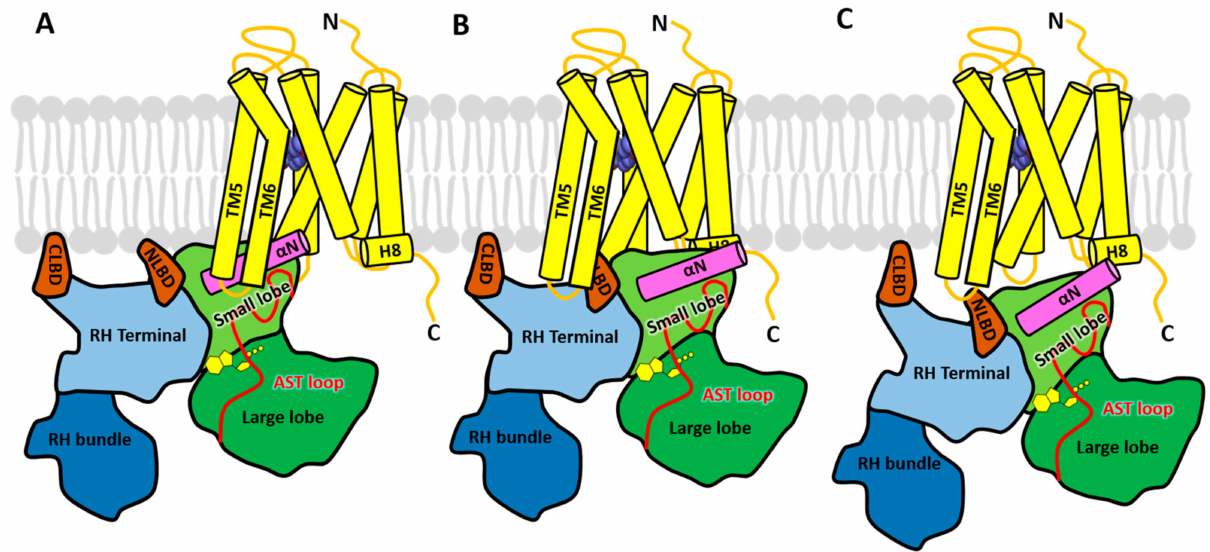
Figure 2. Three models of the GPCR–GRK complex. GRK5 is modeled in complex with the β 2 -adrenergic receptor (yellow cylinders) bound to the agonist epinephrine (purple spheres). The coloring of the structural domains of GRKs is the same as in Figure 1. ( A ) Model 1, in which the N-terminal helix ( α N) forms the primary docking site, was conceived based on crystal structures of GRKs and functional studies of mutants in each of the three GRK subfamilies, and modeled based on similarities with known heterotrimeric G protein complexes with receptors. ( B ) Model 2, in which the NLBD instead docks in the cytoplasmic cleft, is derived primarily from crosslinking with mass spectrometry (CLMS), hydrogen-deuterium exchange mass spectrometry (HDX-MS), and computational studies of a β 2 -adrenergic receptor ( β 2 AR) assembly with GRK5 [49]. The α N helix is not directly involved in receptor contacts. ( C ) Model 3, wherein the NLBD and terminal subdomain are modeled to engage ICL3, was created based primarily on cell-based assays measuring rhodopsin and GRK1 proximity, as well as negative stain electron microscopy (EM) studies of a rhodopsin-GRK5 fusion protein [64]. Unlike the first two models, no element occupies the receptor cytoplasmic cleft. Like Model 2, the α N helix is not directly involved in receptor interactions but proposed to still be important for stabilizing an active kinase domain